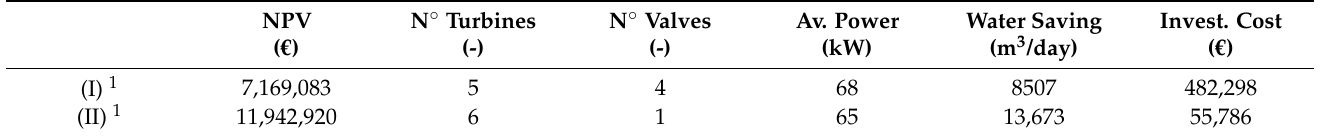
Table 2. Results of the optimization procedure using two different literature cost models.